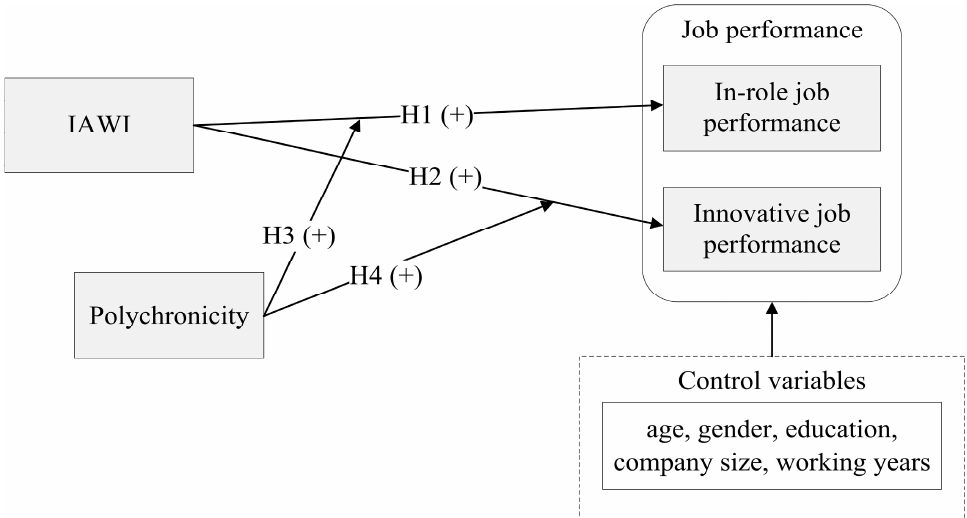
Figure 1. Proposed research model.